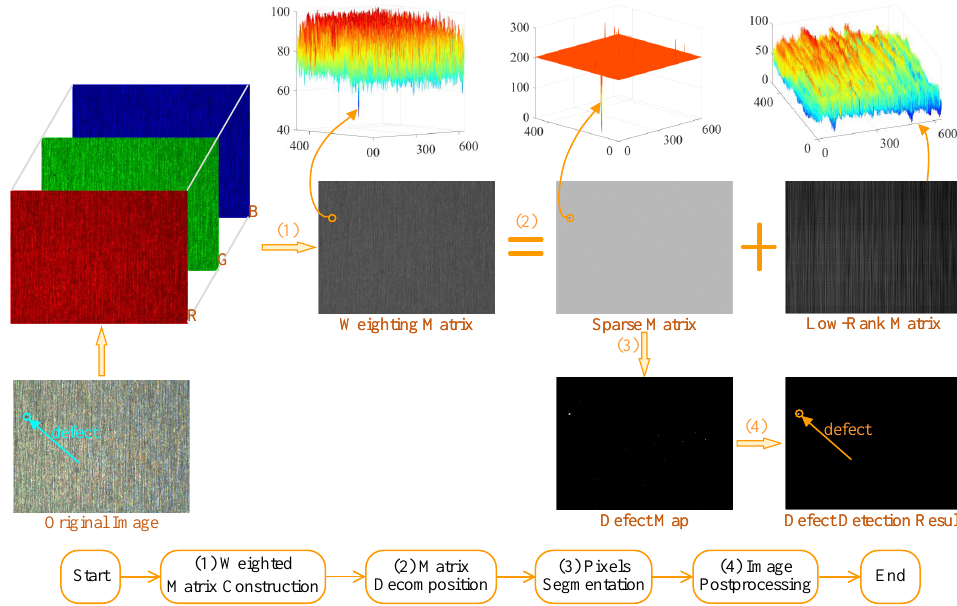
Figure 2. Framework of the WMD model for defect